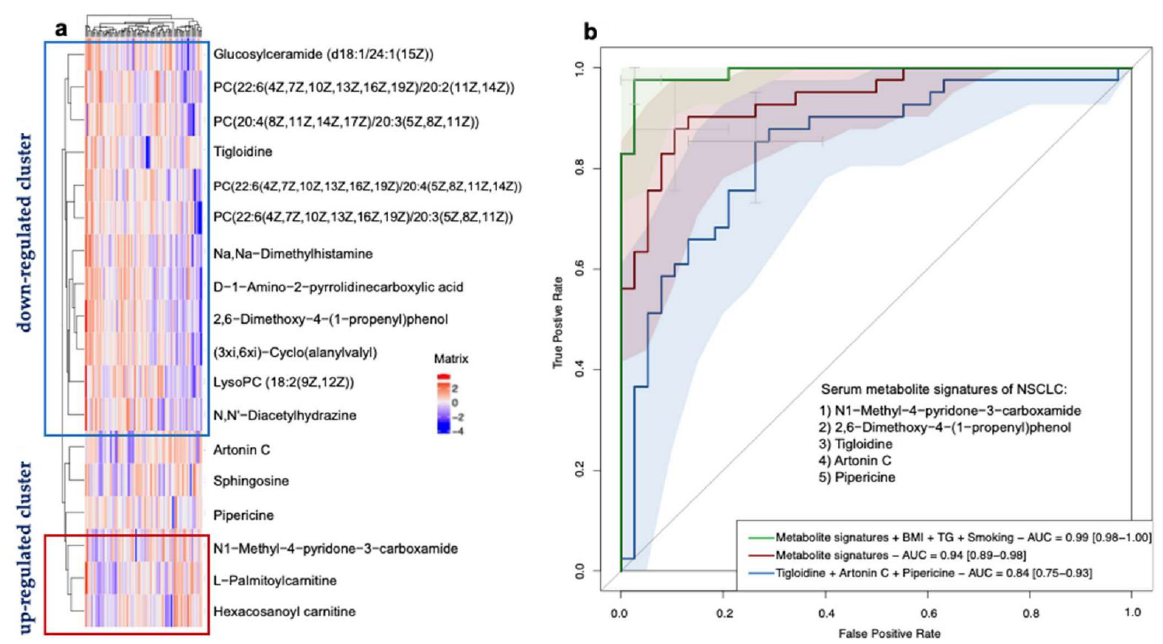
Figure 6. Identification of NSCLC-associated serum metabolite signatures. ( a ) Hierarchical clustering analysis of 18 significantly differentially-expressed metabolites according to OPLS-DA VIP values.